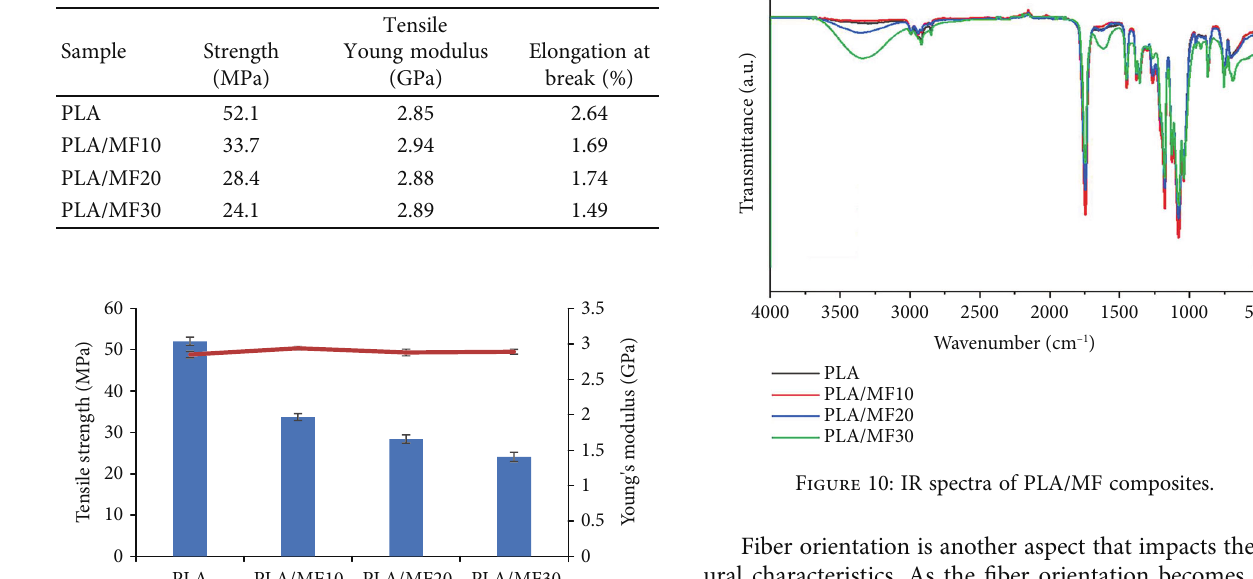
Table 4: Tensile properties of the composite ’ s samples.